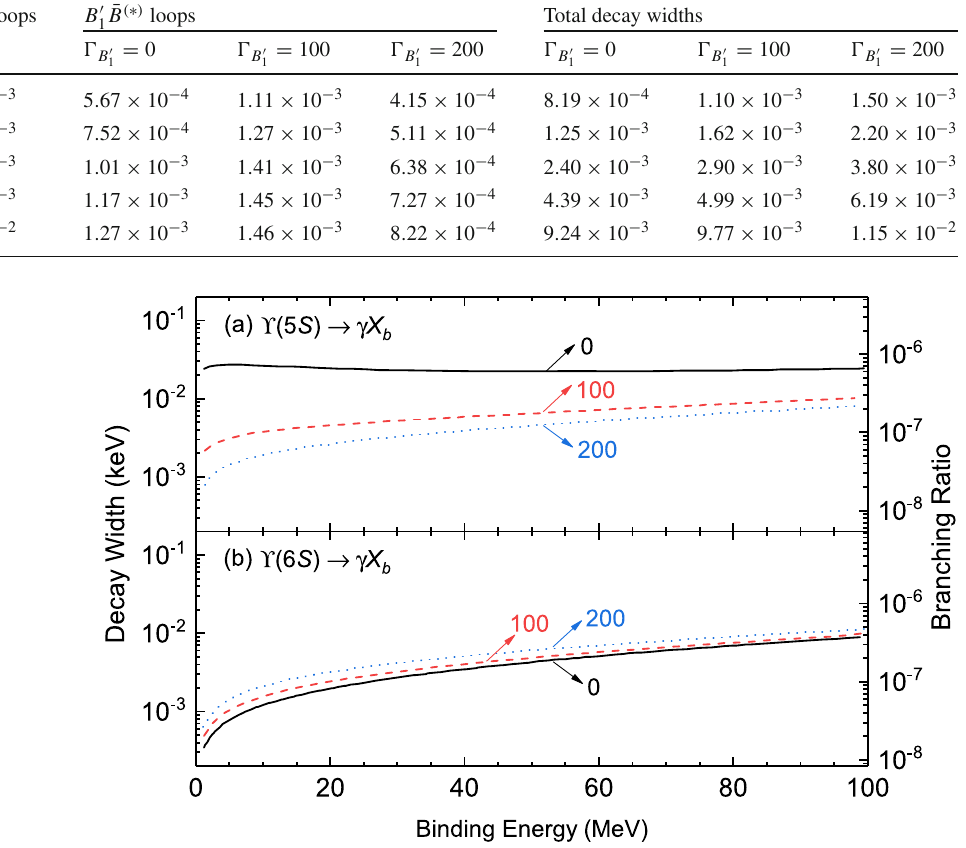
Table 2 The predicted decay widths (in units of keV) of ϒ( 6 S ) → γ X b for different binding energies. Here we choose the (cid:7) B (cid:4) 200 MeV, respectively Binding energy